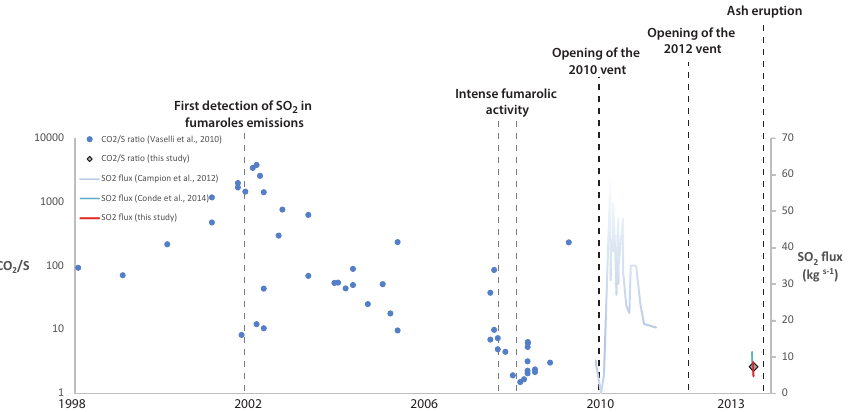
Figure 7. Time series showing the observed evolution of gas emissions in terms of S/CO 2 ratio and SO 2 flux from 1998 to 2013 using data from Vaselli et al. (2010), Campion et al. (2012) and this study. Important events such as vent openings during phreatic eruptions are noted.